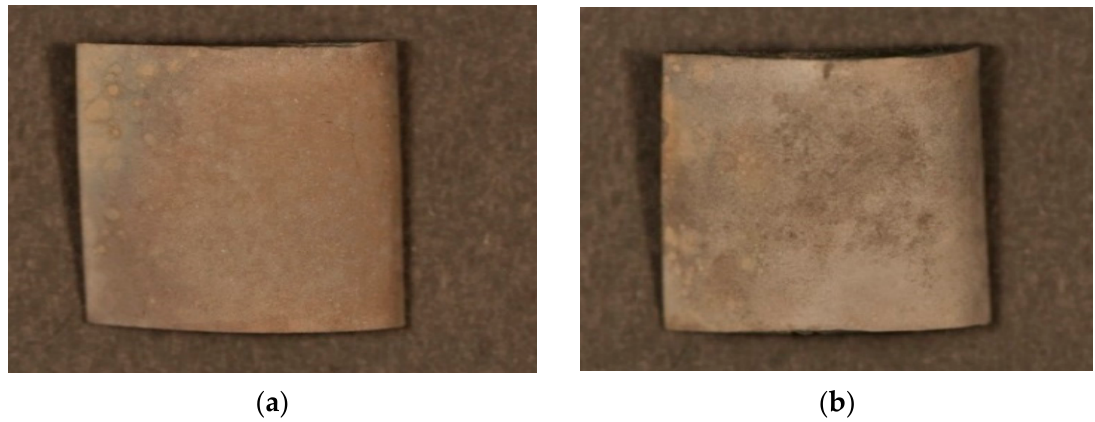
Figure 4. General surface images of blade samples after heating at a temperature of 1323 K in the presence of kerosene exhaust gases for: ( a ) 2 h and ( b ) 3 h (Reprinted with permission from Ref. [2] . 2011, AFIT.).